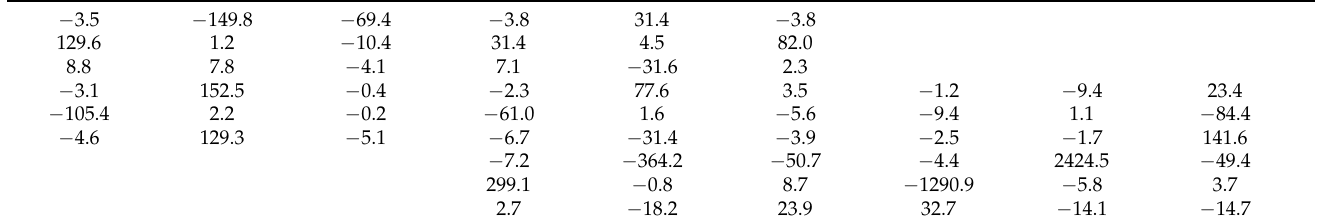
Table 4. Percentage difference of the tangent stiffness matrices of the partial non-linear model between the final deformed configuration of Table 3 and the undeformed configuration of Table 2.